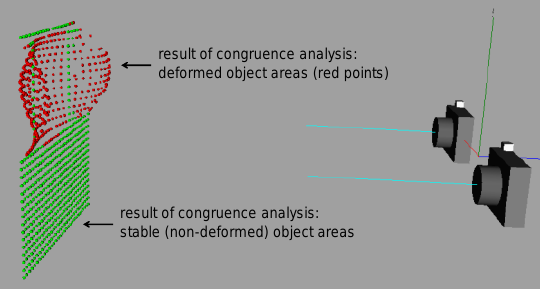
Figure 5. Result of congruence analysis for time t 40